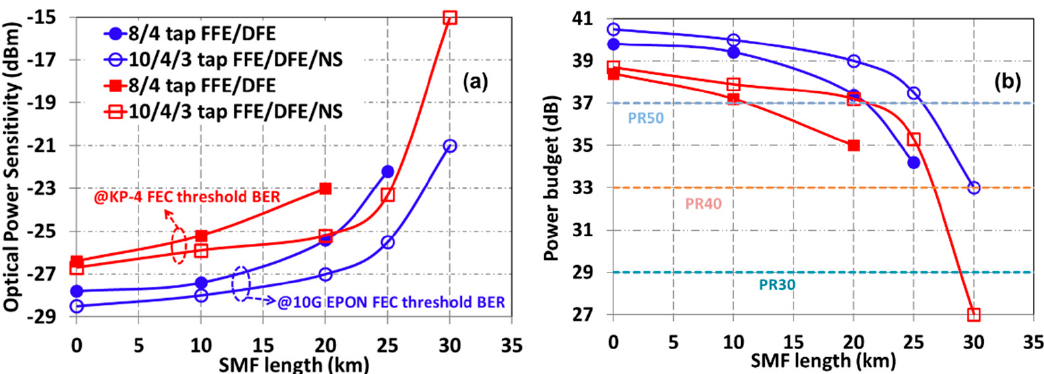
Figure 6. ( a ) Receiver sensitivity and ( b ) the corresponding power budget at different fiber lengths of the 40 Gb/s PAM-4 system.